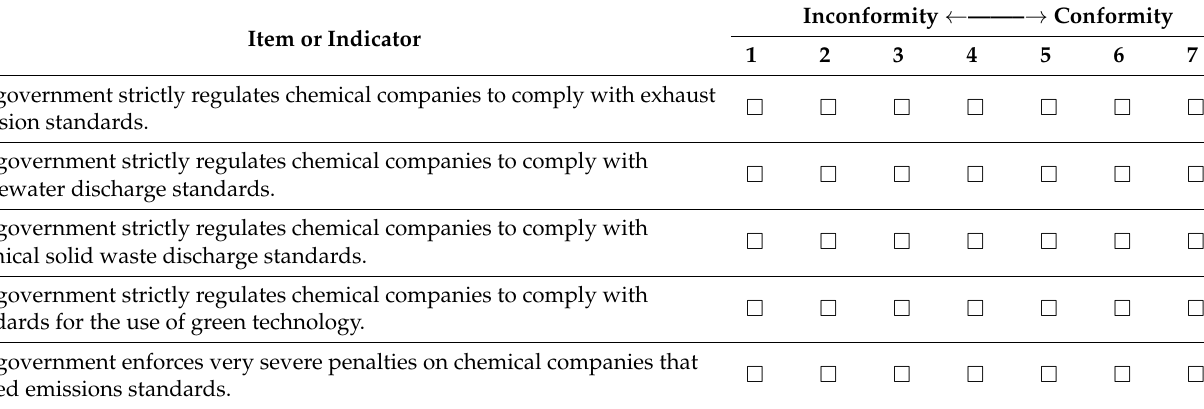
Item or Indicator